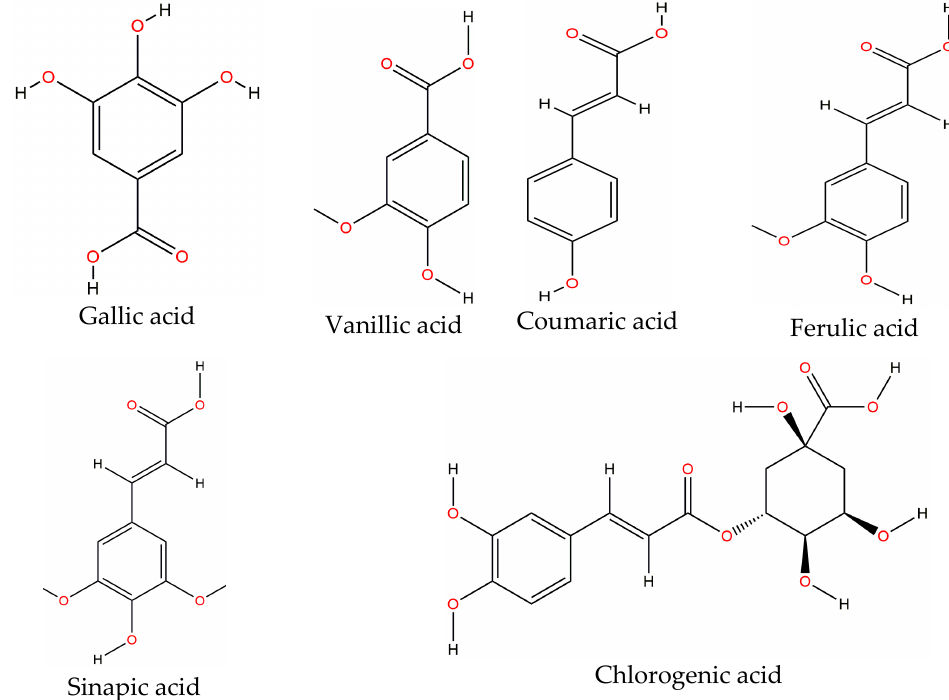
Figure 3. Structures of major phenolic acids of P. vulgaris [46].